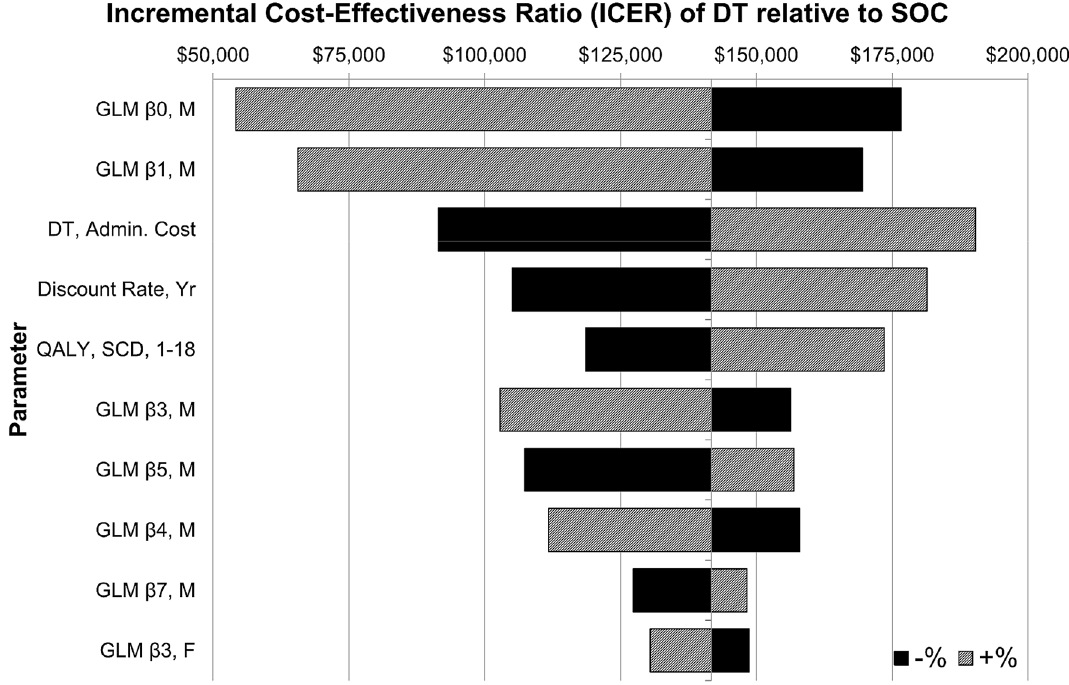
Figure 3. Tornado diagram of deterministic sensitivity analysis results (top ten). Parameters were varied univariately within their 95% CIs, or ± 20% when unavailable. CI confidence interval, SOC standard of care,